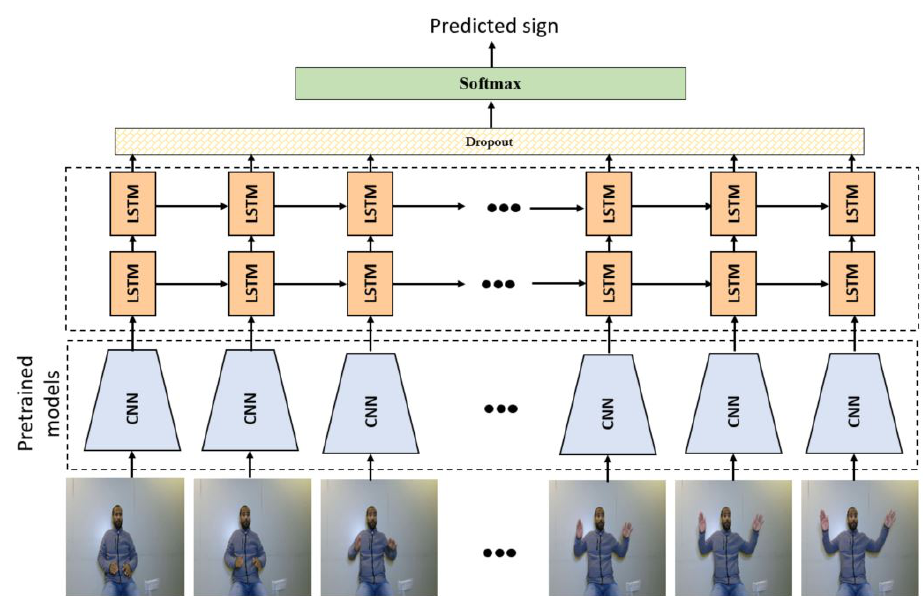
Figure 5. Framework of the proposed system where two variants of CNN are used in the pilot study: transfer learning with fine tuning and customized